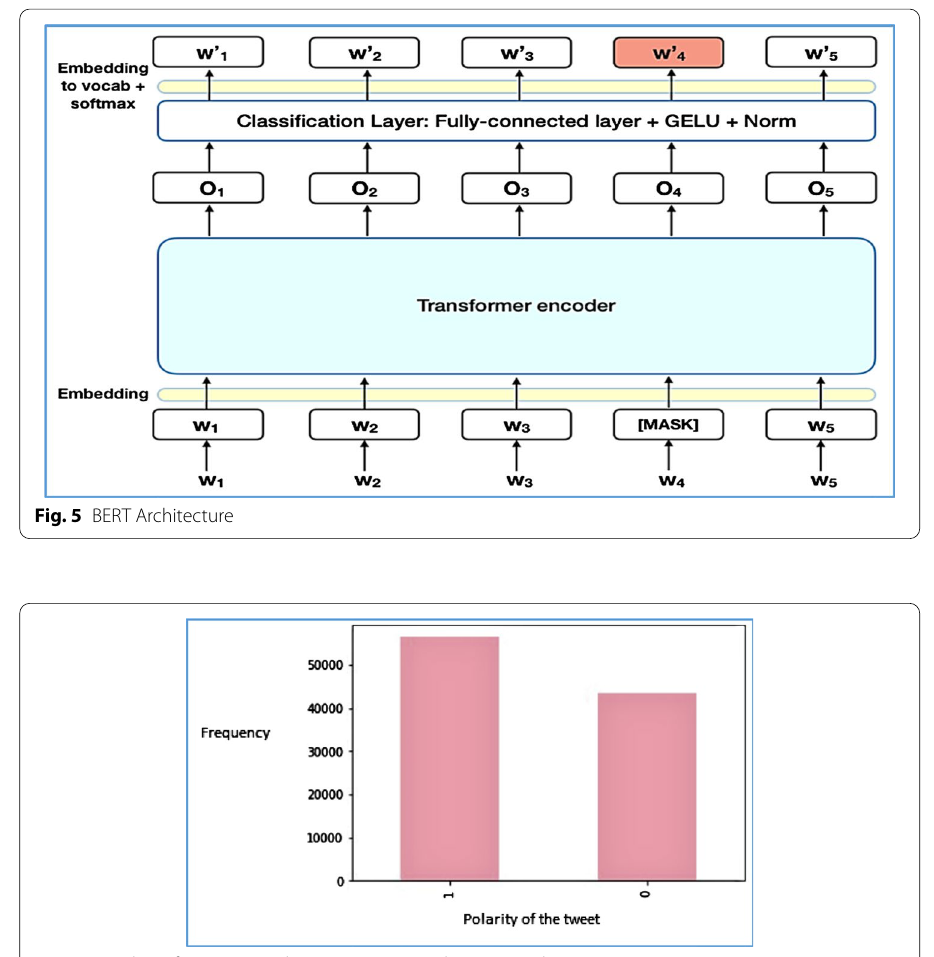
Fig. 6 Number of Negative and Positive Tweets in the training